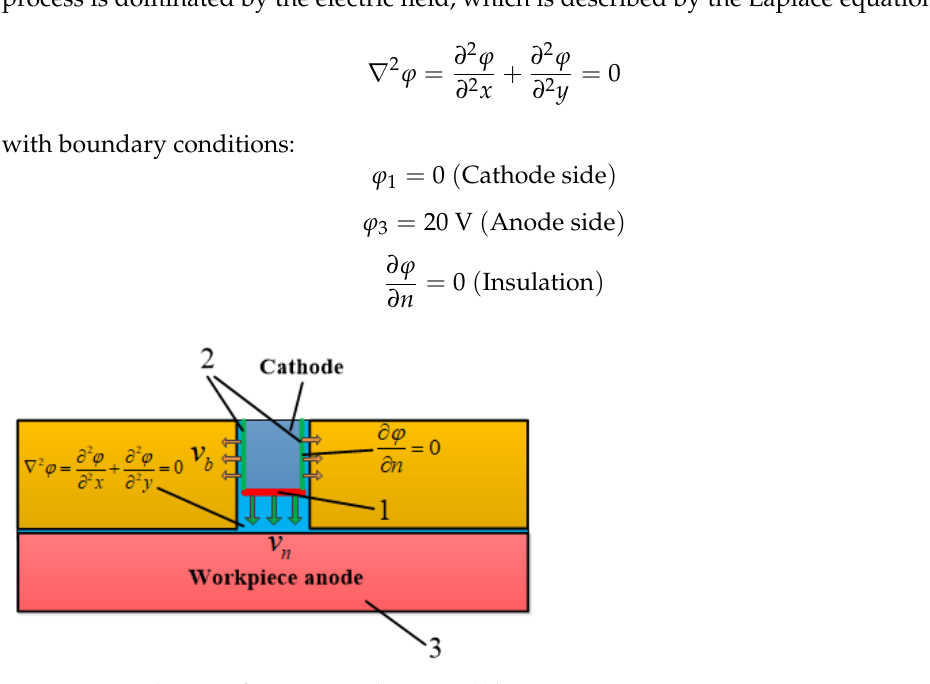
Figure 4. ECB dynamic forming simulation model.